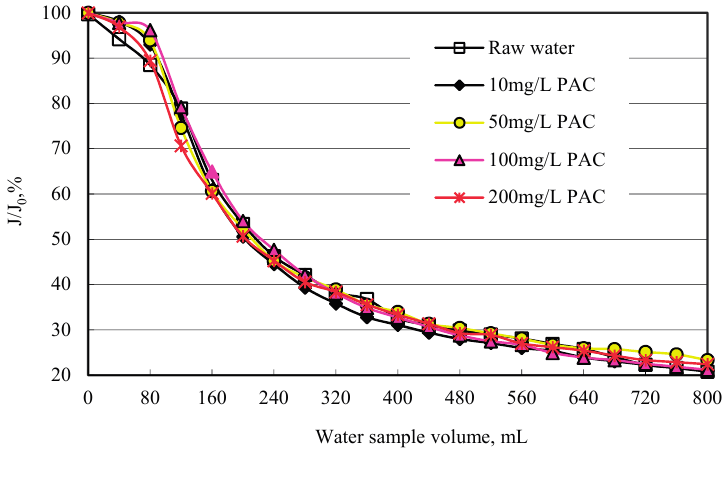
Figure 5. Membrane flux variation with different PAC